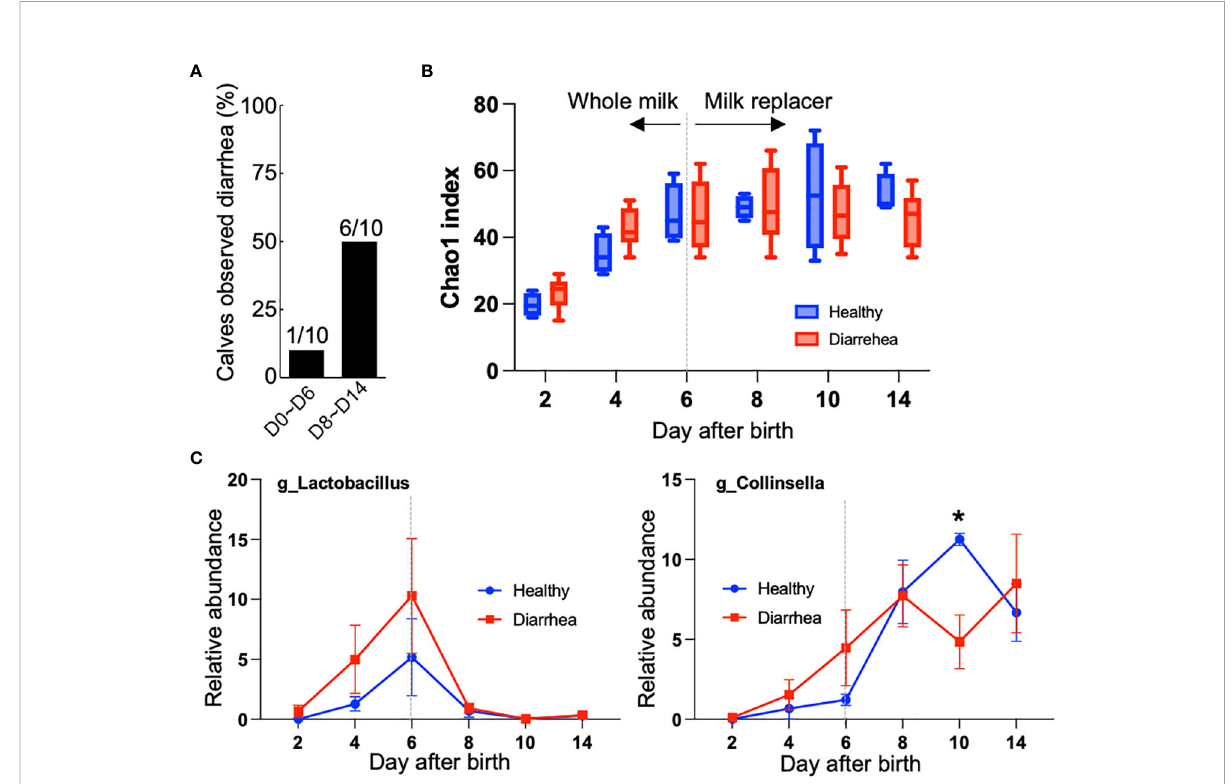
FIGURE 4 Differences in fecal microbiome between healthy calves and diarrheal calves. (A) Number of calves with diarrhea in the fi rst or second week after birth. (B) Chao1 index of alpha diversity during milk transition. Calves were divided into two groups (i.e., four healthy calves and six diarrheal calves) based on the observation of diarrhea in the second week after birth. (C) Changes of Lactobacillus and Collinsella in feces from healthy and diarrheal calves during milk transition. Asterisk indicates signi fi cant difference between healthy calves and diarrheal calves using the Bonferroni Correction with Dunn Test method ( p < 0.05).